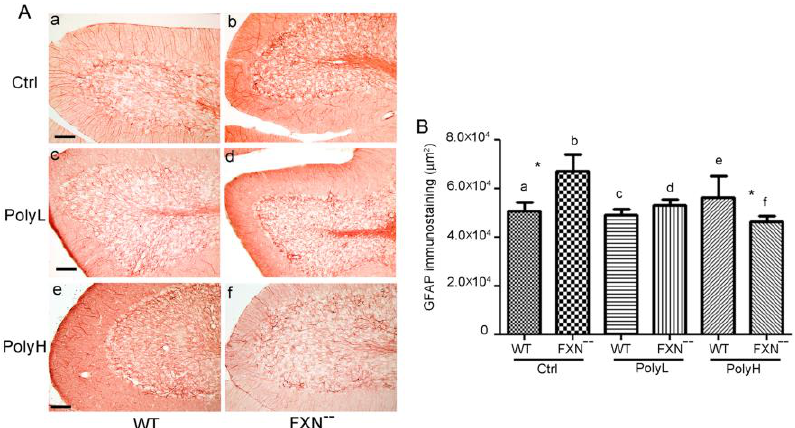
Figure 8. ( A ): Expression of the Glial Fibrillary Acidic Protein (GFAP) in the cerebellar folium of WT and FXN -- mutant mice at the 6th month. Vermal sections from FXN -- mice displayed a significant increase of GFAP expression compared to WT littermates in the absence of any treatment (Ctrl, a,b). On the other hand, minor differences between the genotypes were observed in the presence of treatments with either low (PolyL; 0.0185 mg/g, c,d) or, respectively, high (PolyH; 0.185mg/g, e,f) EGCG concentrations in the diet. In this last case, a downregulation of GFAP expression was even observed. Scale bar: 50 µm. ( B ): Morphometric analysis of Glial Fibrillary Acidic Protein (GFAP) expression in the folium of WT and FXN -- mice reported in A . A significant (*) increase in GFAP expression (32%, p = 0.038) was observed in FXN -- compared WT mice, while minor differences among the genotypes were found in the presence of low (PolyL; 0.0185 mg/g, c,d) with even a decrease in the presence of high (PolyH; 0.185 mg/g, e,f) dietary EGCG administration.